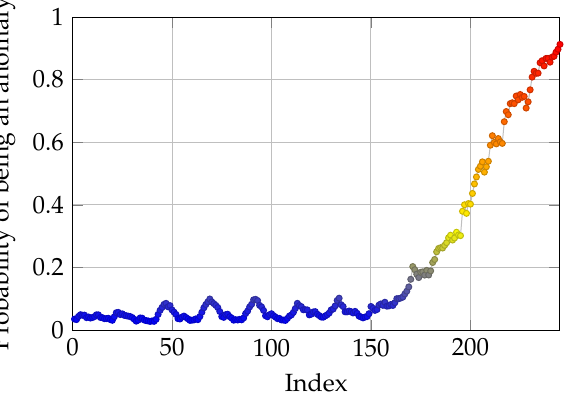
Figure 12. Results of simulation from optimized sigmoid function. Lower oscillation in HI values due to the optimization, which makes the HI time-series more